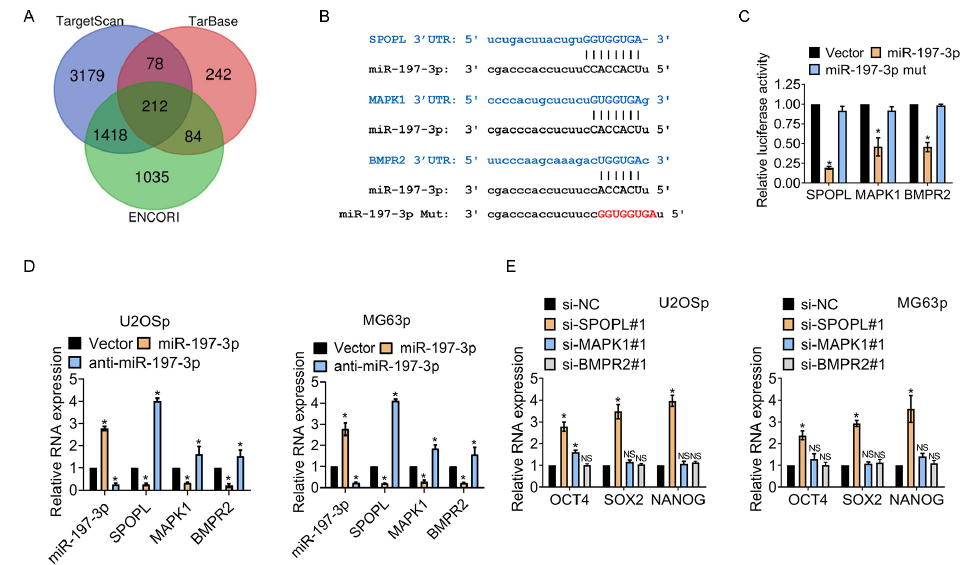
Figure 4. miR-197-3p maintains the stemness of osteosarcoma cells by targeting SPOPL. ( A ) The Venn diagram shows the predicted target genes of miR-197-3p. ( B ) The schematic shows the binding sites of miRNA and potential targets. ( C ) Cells were transfected with vector, miR-197-3p, or miR-197-3p mut. The promoter activity of the indicated genes was determined by dual luciferase assay. Mut indicates mutation. ( D ) The indicated gene expression was assessed by qPCR assay. ( E ) The indicated gene expression was assessed by qPCR assay. * p < 0.05; NS, no significance. Results represented the mean ± S.D. of three independent experiments. U2OSp, the parental U2OS.